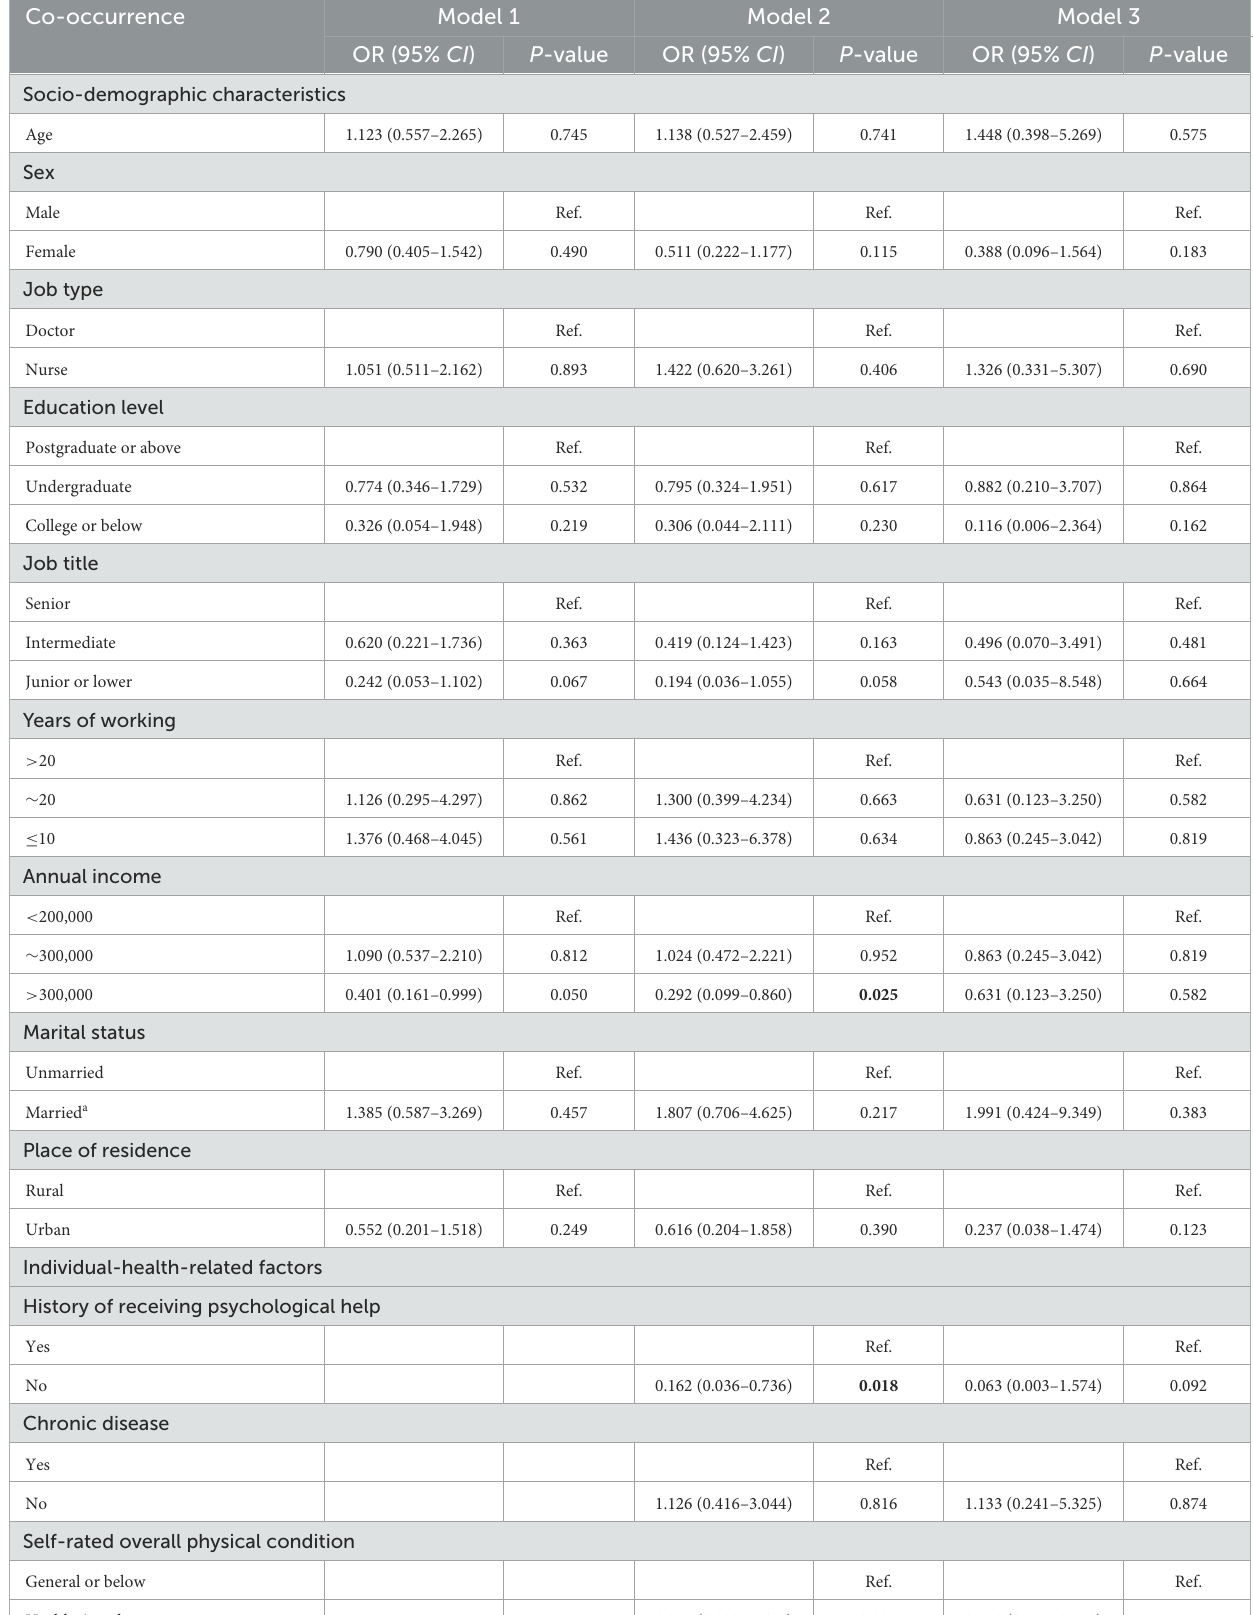
TABLE 4 Logistic regression analysis of the co-occurrence of the symptoms of depression and anxiety in the